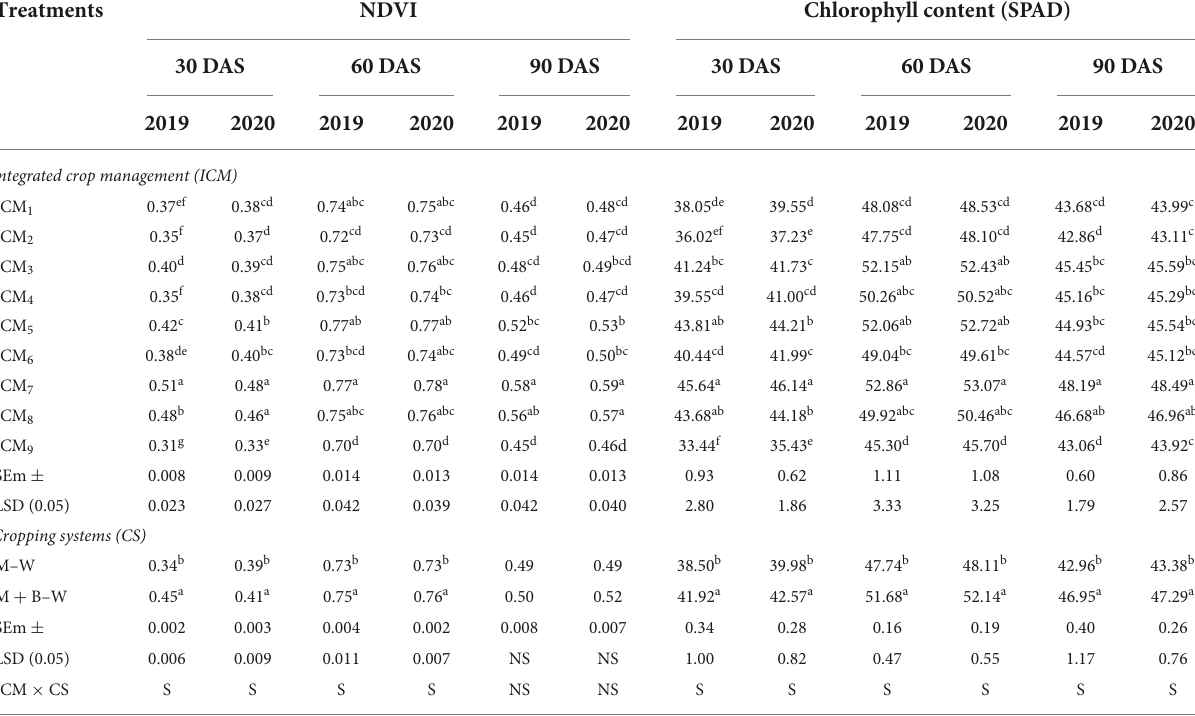
TABLE 4 Effect of different ICM modules and cropping system on Normalised Difference Vegetation Index (NDVI) and chlorophyll content (SPAD) in maize at 30-days interval a . Treatments NDVI Chlorophyll content (SPAD) 30